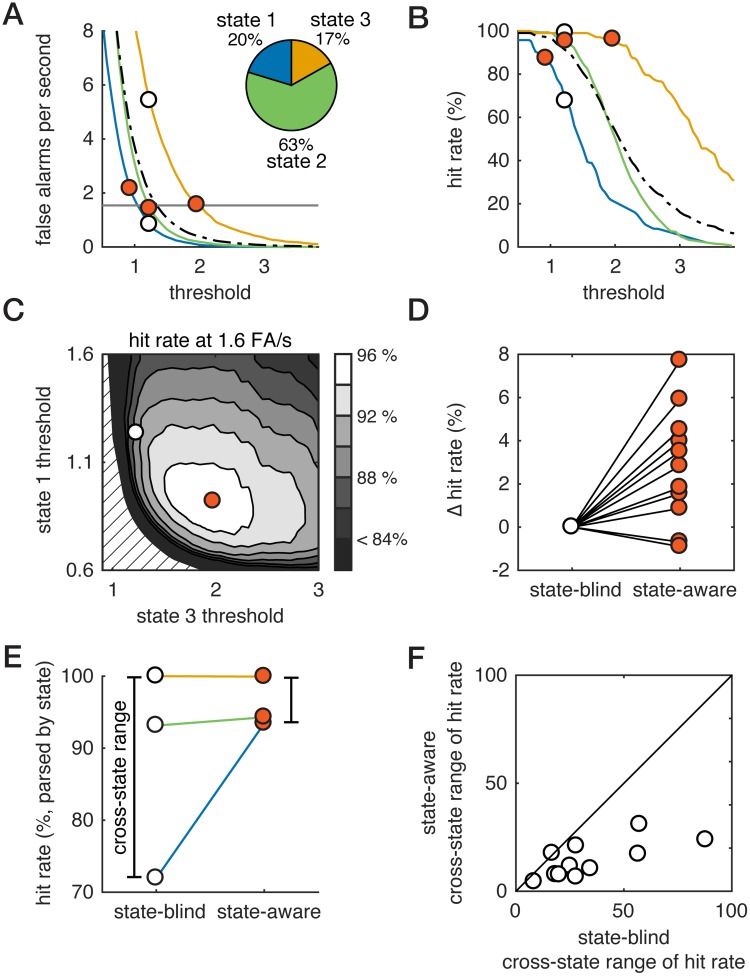
Optimizing thresholds for the state-aware observer.A. False alarm (FA) rate vs. threshold for each pre-stimulus state (colors) as well as the full dataset (black dashed). Pie chart: fraction of time spent in each state. White fill circles: threshold for state-blind observer. Vermillion fill circle: threshold for state-aware observer (see C). Combined with the fraction of time spent in each state (pie, A), this sets the overall FA rate. B. Hit rate vs. threshold for each pre-stimulus state (colors) as well as the full dataset (black dashed). Combined with the fraction of time spent in each state (pie, A), this sets the overall hit rate. Circles marks same thresholds as in (A). C. Hit rate of state-aware observer for combinations of threshold that generate the same (1.6 Hz) FA rate is indicated by grayscale. Circles correspond to the combinations of thresholds shown in A and B. Dashed lines show region with no solution satisfying constraint on FA rate. D. Change in hit rate between state-blind and state-aware observers. Thresholds are chosen based on the optimization shown in (C), and hit rates are computed on a reserved set of trials and compared to the fixed-threshold hit rate at equivalent false alarm rate. E. For the example recording, we parse hit rate by pre-stimulus state for the state-blind and state-aware observers. The cross-state range of hit rates is defined as the range of hit rates observed across the three states. F. Cross-state range of hit rates for the state-aware observer versus cross-state range for the state-blind observer (see D). The cross-state range is smaller for the state-aware observer, meaning that hit rates are more consistent across pre-stimulus states for the optimal state-aware observer.